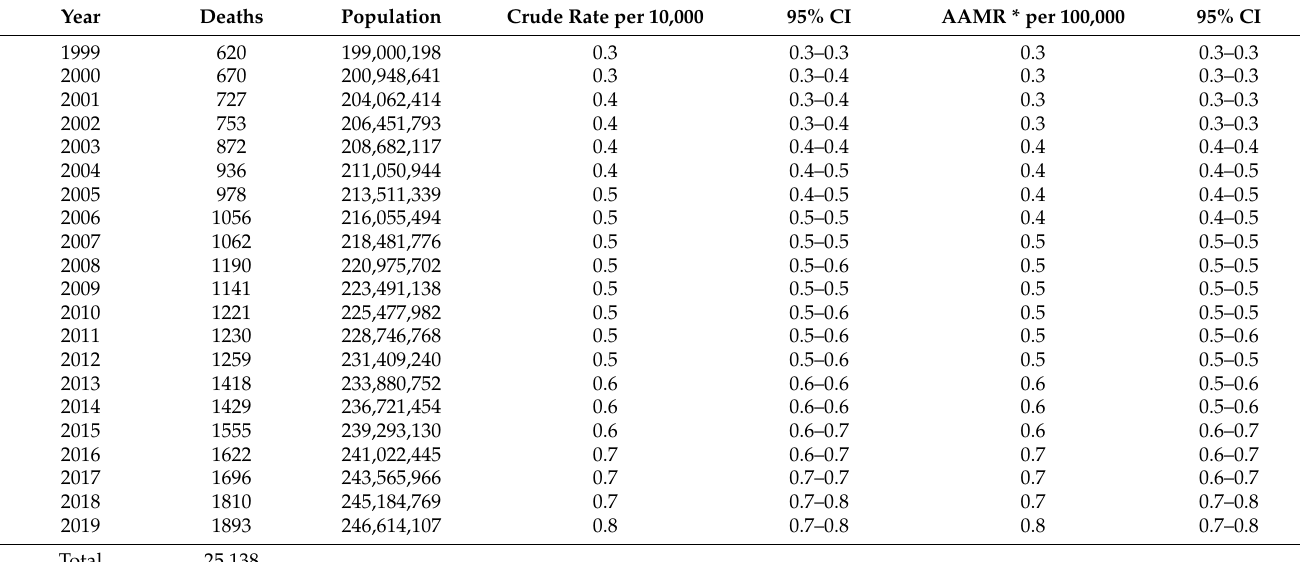
Table 1. Trends of “cerebral palsy” (G80x: Infantile cerebral palsy) listed as the underlying cause of death from 1999 to 2019.